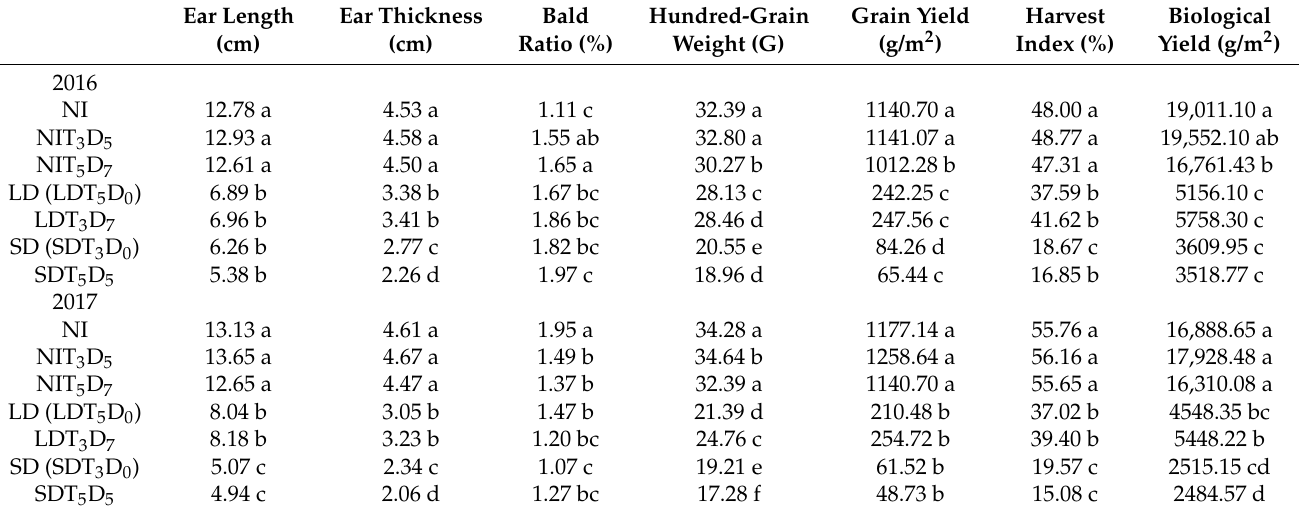
Table 5. Effects of different treatments on maize yield and yield